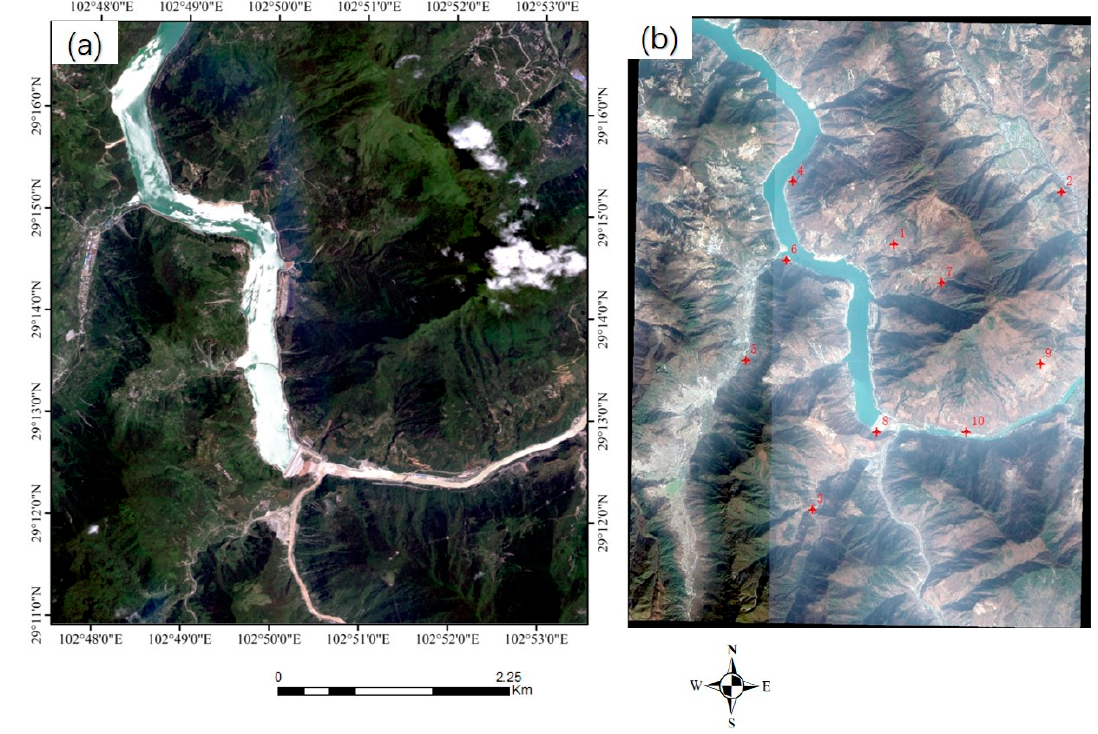
Figure 9. The Yaan earthquake dataset. The left (a) is the post-earthquake image (the input image), and the right (b) is the reference image in the pre-earthquake database. The points in red are the verification points used for calculating the accuracy of the rectified image.